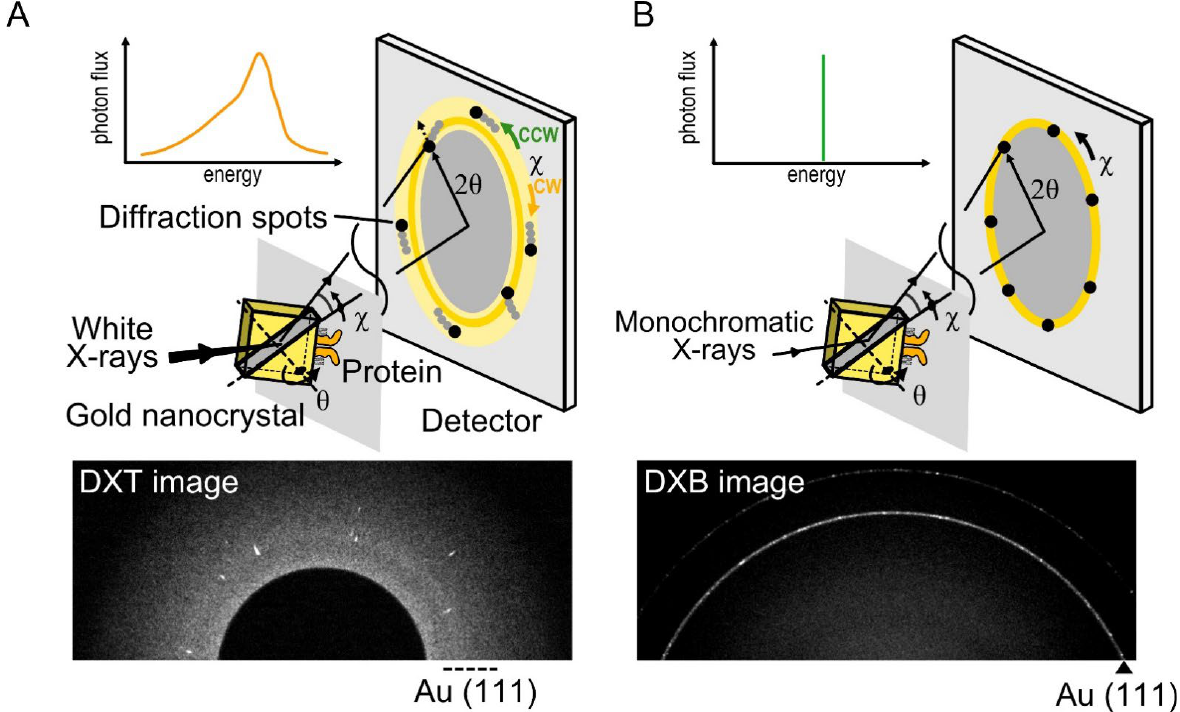
Figure 2. Diffracted X-ray tracking (DXT) and diffracted X-ray blinking (DXB) methods. ( A ) In DXT, the specific domain of a target protein is labeled with gold nanocrystals, with a diameter of 40 nm to 80 nm. The diffraction spots represent the tilting ( θ ) and twisting ( χ ) motions. DXT using white X-rays can analyze the trajectories of Laue spots appearing over a wide detector area. ( B ) DXB uses monochromatic X-rays, and the diffraction spots appear on the diffraction rings. The intramolecular motions are analyzed from the intensity changes of the Au (111) diffraction rings.